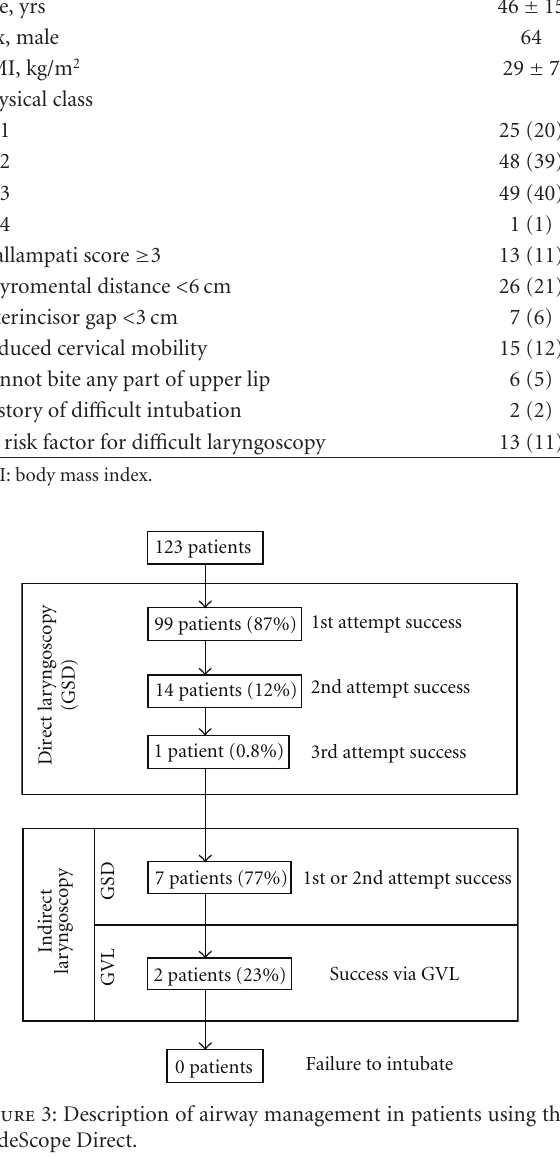
Table 2: Number of intubations performed by prior training and intubation